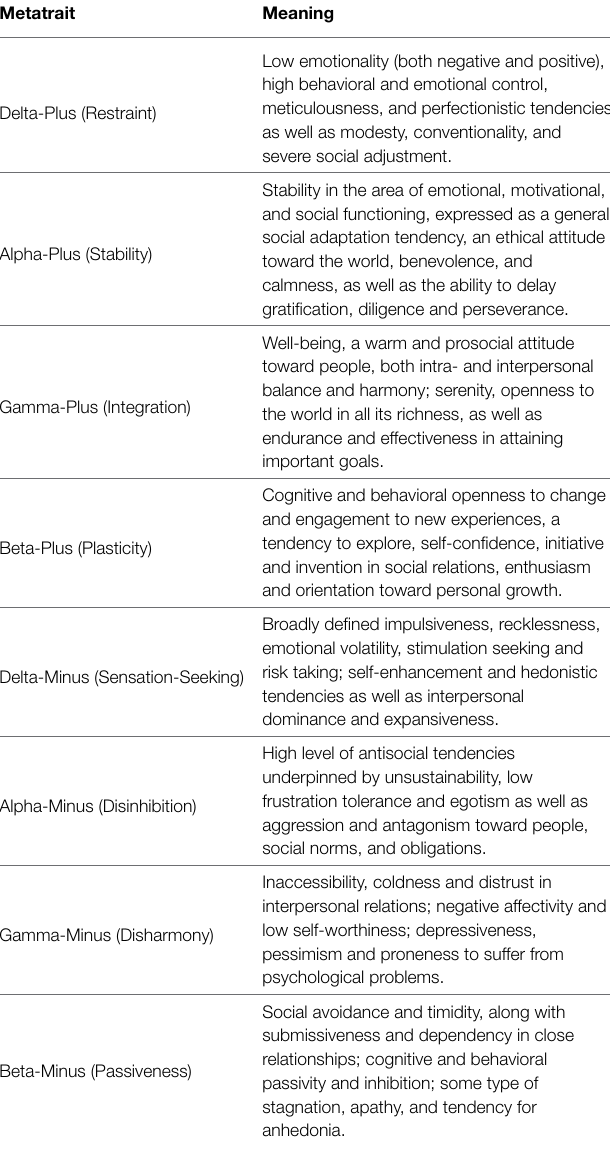
TABLE 3 | Description of the eight metatraits in the revised Circumplex of Personality Metatraits.